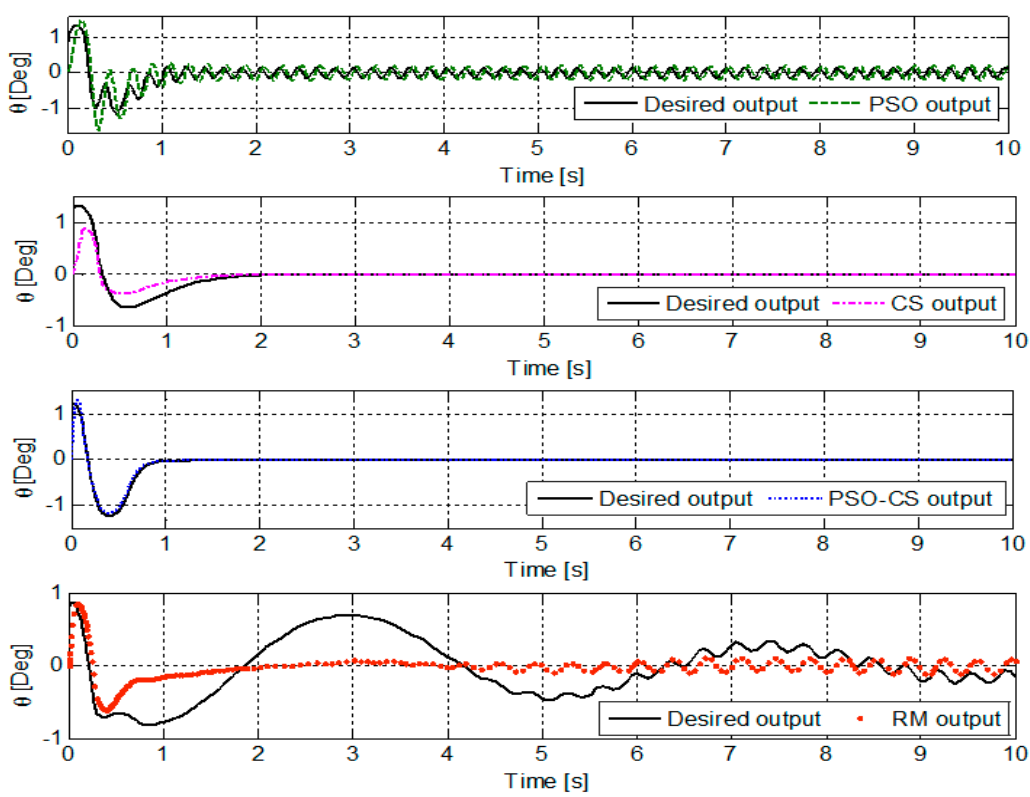
Figure 8. Quadrotor’s pitch attitude ( θ ) using Particle Swarm Optimization (PSO), Cuckoo Search (CS), Particle Swarm Optimization-Cuckoo Search (PSO-CS), and Reference Model (RM).